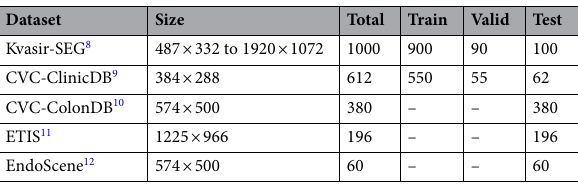
Table 1. Original dataset summary.